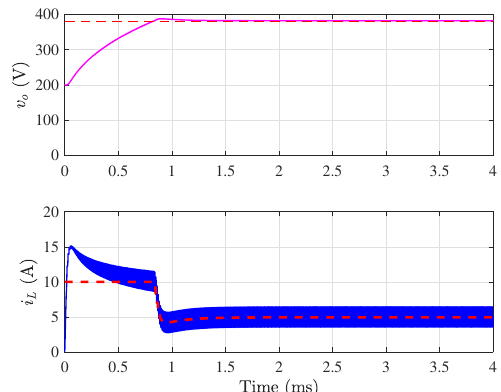
Figure 14. Startup and steady-state response from numerical simulations using a detailed switched model implemented in PSIM c (cid:13) when the samples of the output voltage are replaced by their steady-state value in (41) but using the instantaneous values of the output voltage in the expression of i ref given by (37).